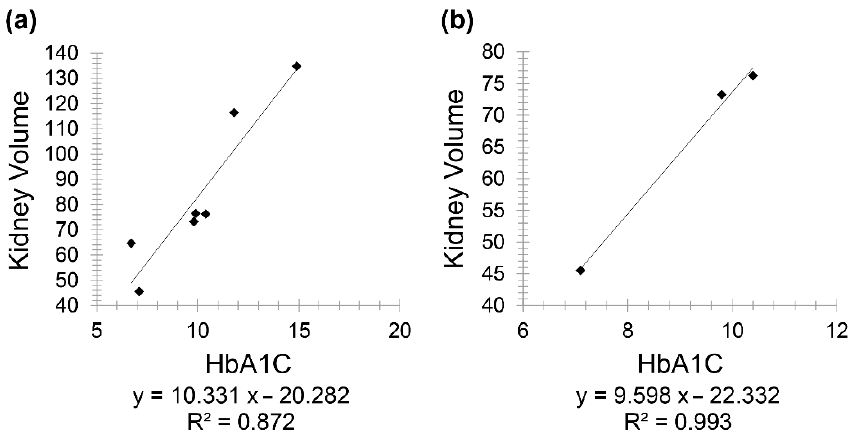
Figure 7. Scatter plot graphs showing ( a ) positive correlation between kidney volume and HbA1C ( r = 0.9333) and ( b ) positive correlation ( r = 0.996) between the same variables in uncontrolled diabetic CKD patients for 20 years and above.